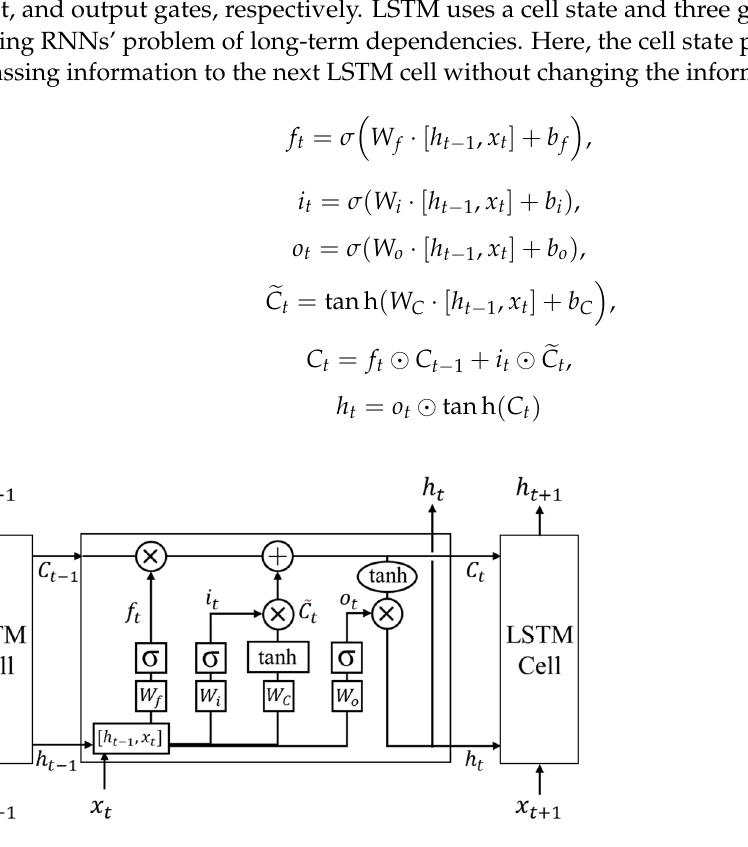
Figure 4. Waveform of the motor’s vibrations: ( a ) a normal motor; ( b ) an abnormal motor.